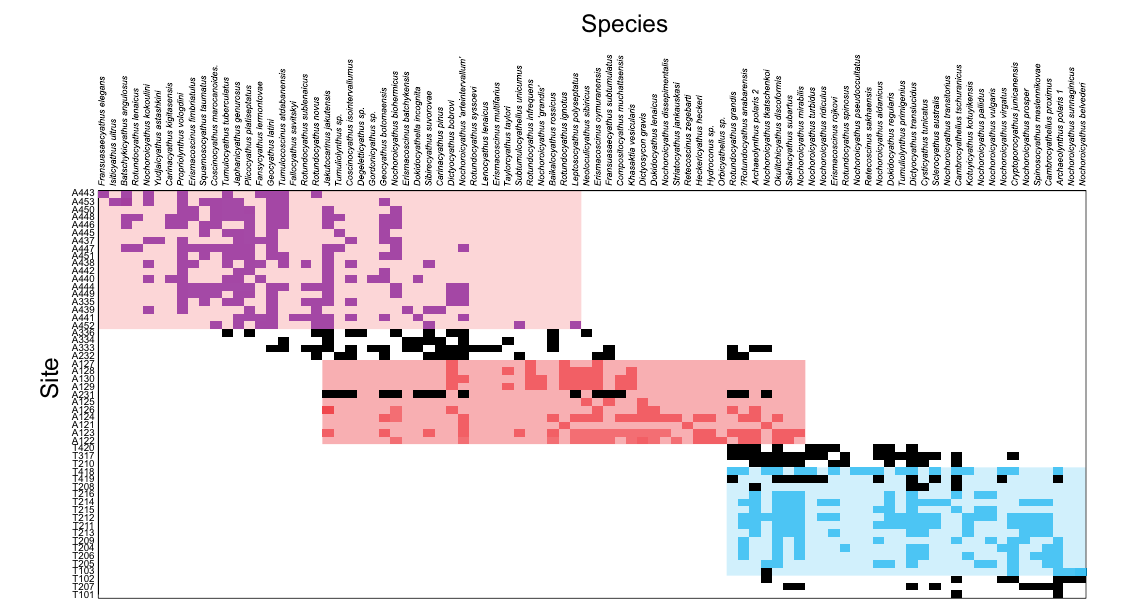
Fig.4|Ordereddatausedformetacommunityanalyses. Sites(rows)andspecies (columns) are ordered based on the similarity of community composition, i.e. the numberofco-occurringspeciesbetweensites,asdeterminedbythe fi rststepofthe metacommunity analyses calculated using reciprocal averaging based on com- munity composition using the R package metacom 63 . The presence of a species is indicated by differently coloured squares which correspond to different time intervals: Tommotian 2 (T2; blue), Atdabanian 1 (A1; red) and Atdabanian 4